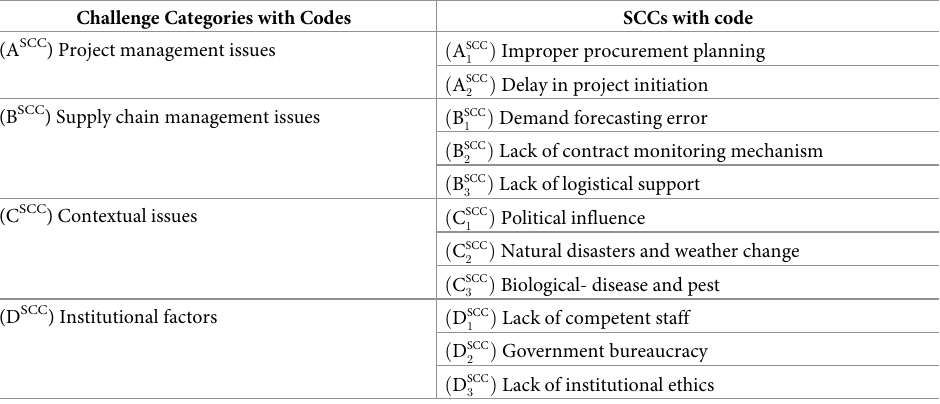
Table 2. Key SCCs identified through the modified Delphi